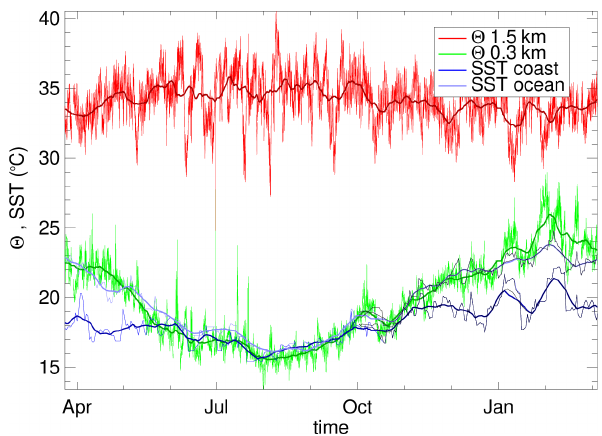
Figure 15. Air and ocean temperatures from April 2018 to March 2019 with potential temperature with reference pressure at sea level ( (cid:50) ) from MWR measurements for 1.5 (red) and 0.3km (green) height and sea surface temperature (SST) 5km from the coast (light blue) and 50km to the southwest in the open ocean (dark blue). Thin lines indicate 15min ( (cid:50) ) or daily (SST) values, whereas thick lines are 30d gliding